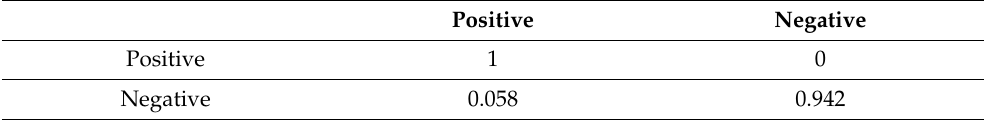
Table 17. Confusion matrix of the proposed ensemble model for D2, i.e., the Coswara cough dataset.